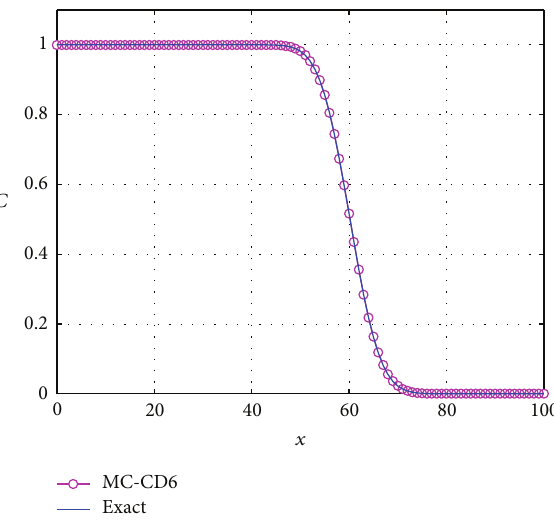
Figure 2: Comparison of the exact solution and the numerical solution obtained with MC-CD6 scheme for 𝑡 = 6000